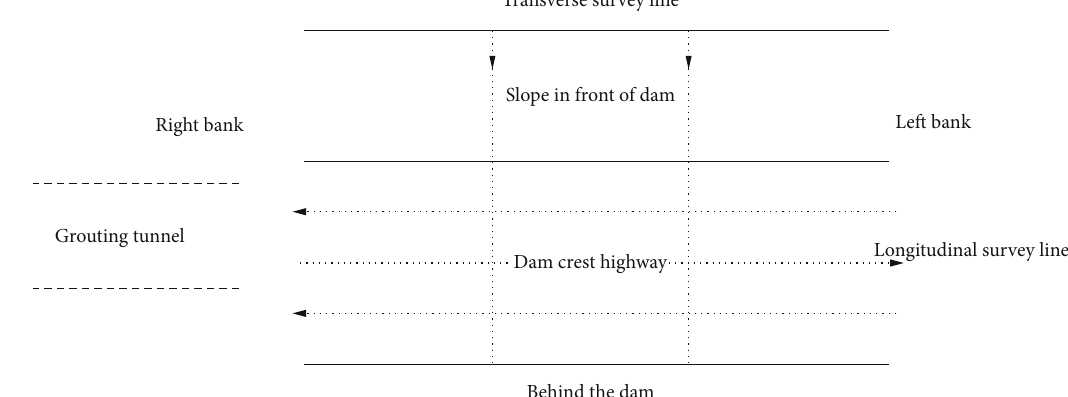
Figure 15: Schematic diagram of ground penetrating radar survey line layout.